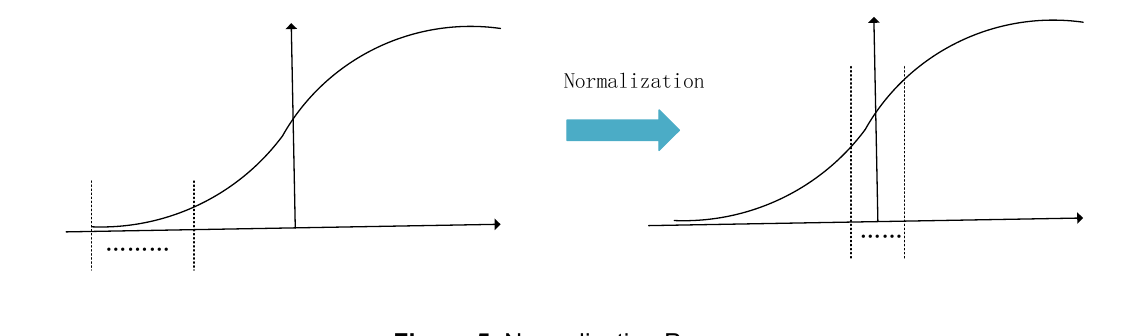
Figure 5. Normalization Process